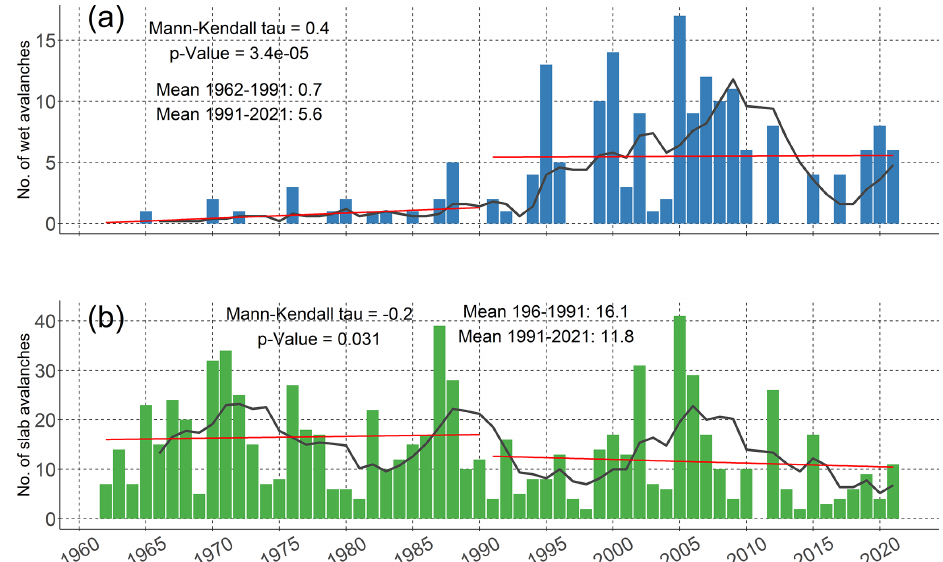
Figure 2. Occurrence of wet and slab avalanches over the winter seasons 1962–2021. Each year represents the winter season (1 October– 31 May). The trend was analysed by Mann–Kendall τ ; its significance was estimated by the p value for two periods, 1962–1991 and 1991–2021 (red line), and the five-season moving average (black line). The count of avalanches for each subperiod is calculated as a seasonal mean.